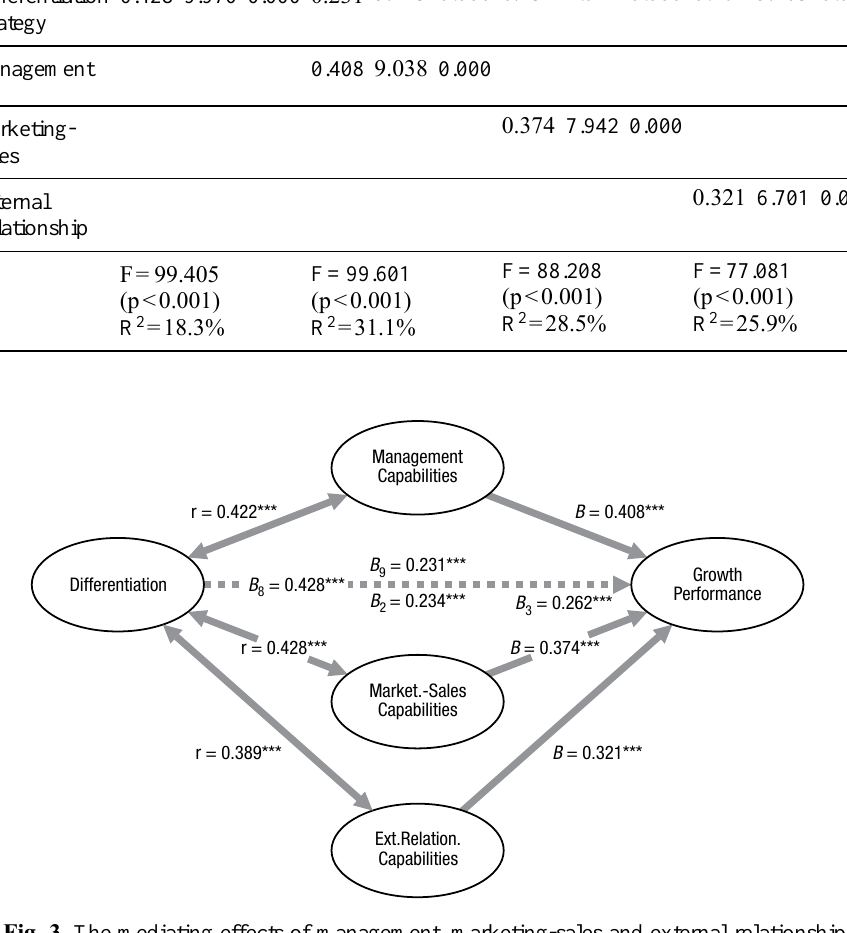
Fig. 3. The mediating effects of management, marketing-sales and external relationship capabilities on the relationship between differentiation strategy and growth